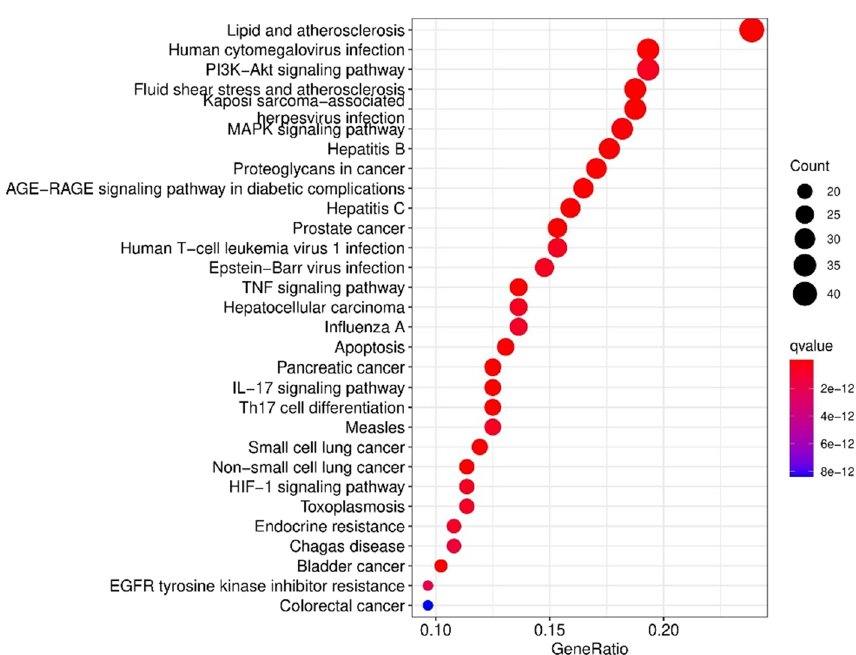
Figure 5. The top 30 pathways for KEGG enrichment analysis of the targets of ginseng